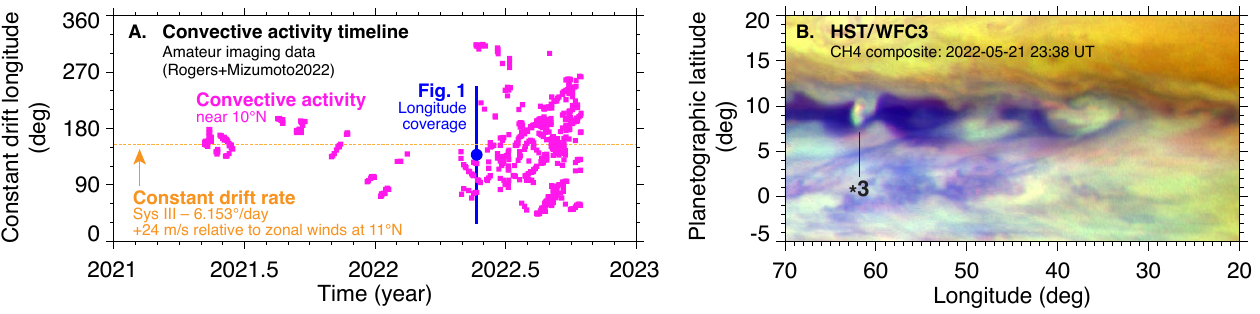
Figure 4. Convective activity in the North Equatorial Belt (NEB) was atypical in the 2021–2022 timeframe. ( A ) Throughout 2021, convective activity shut off in the NEB, except for episodic